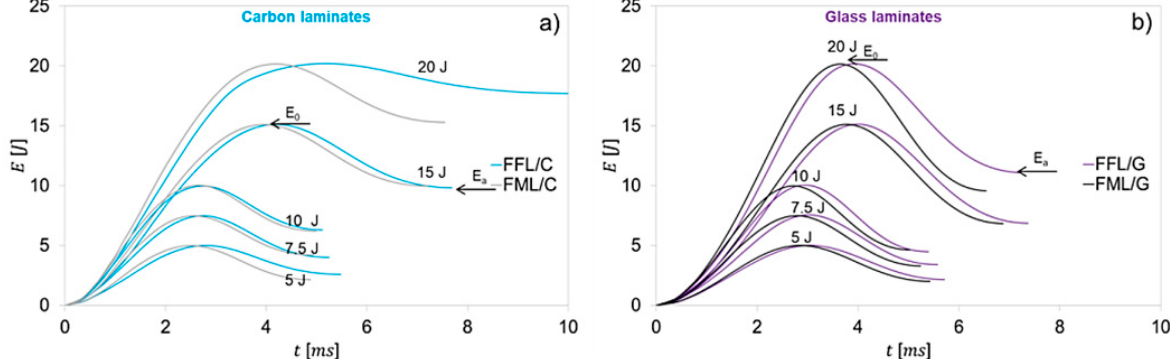
Figure 7. Experimental Energy–time curves of ( a ) FFL/C, FML/C and ( b ) FFL/G, FML/G impacted with the energy ranging from 5 J to 20 J.